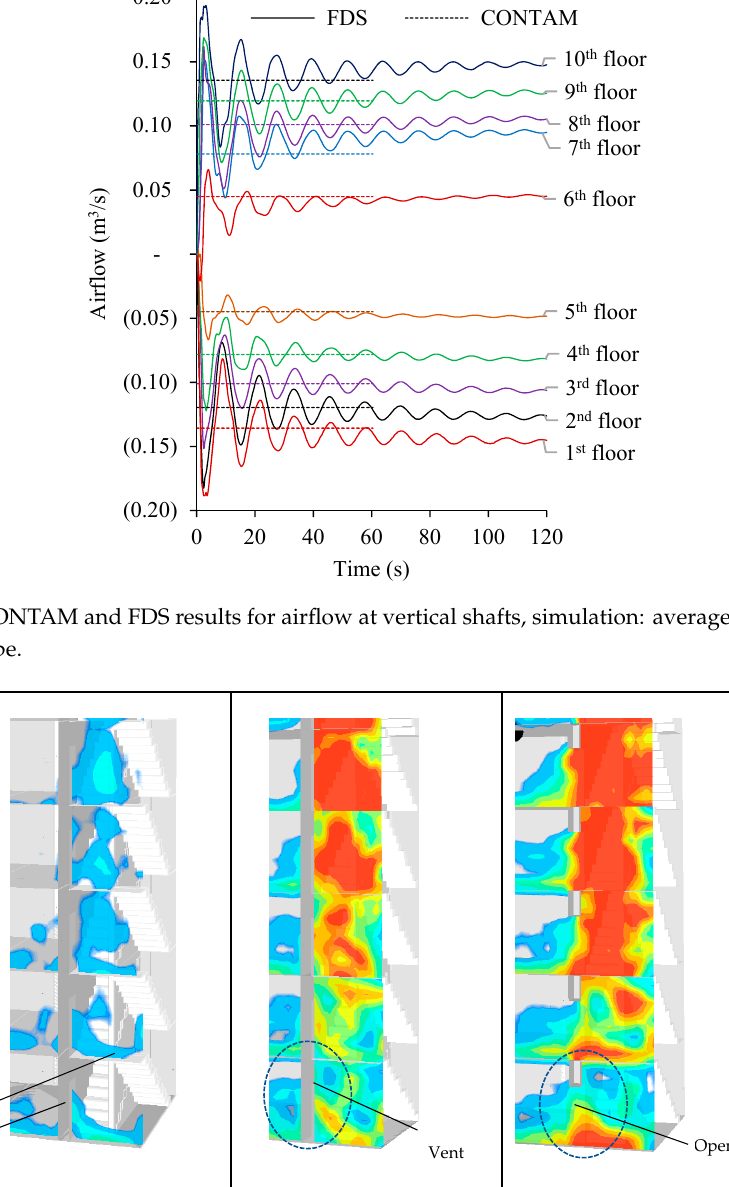
Figure 10. CONTAM and Fire Dynamics Simulator (FDS) results for airflow at vertical shafts, simulation: tight stairwell and leaky envelope.